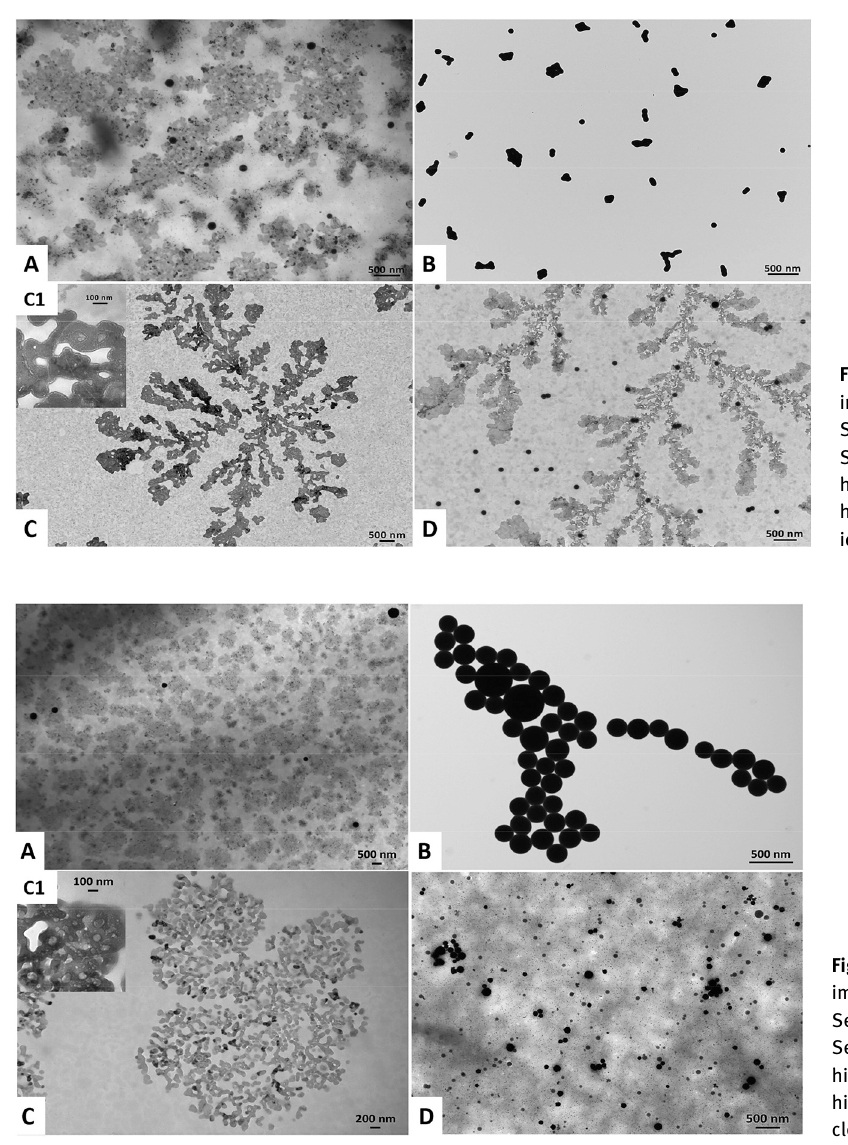
Figure 2: Transmission Electron Microscopy images of (A) Bio SeNP extract_NB, (B) L -cys SeNPs_1:4 (C) OM_NB, and (D) L -cys SeNPs_1:4 + OM_NB. The inlet (C1) shows a high magni fi cation image of the OM_NB highlighting the presence of lipid-like vesi- cles.